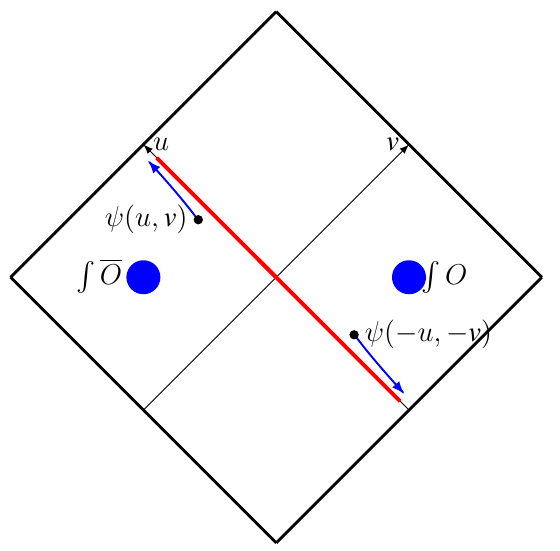
Figure 3 . Kinematics for the derivation of the holographic null energy condition. Operators O s are smeared over some regions in a Rindler reflection symmetric way.